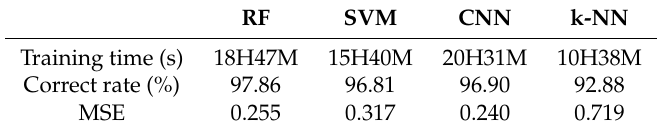
Table 3. Results of classification algorithms: RF, SVM, CNN, k-NN of NIST-DB4